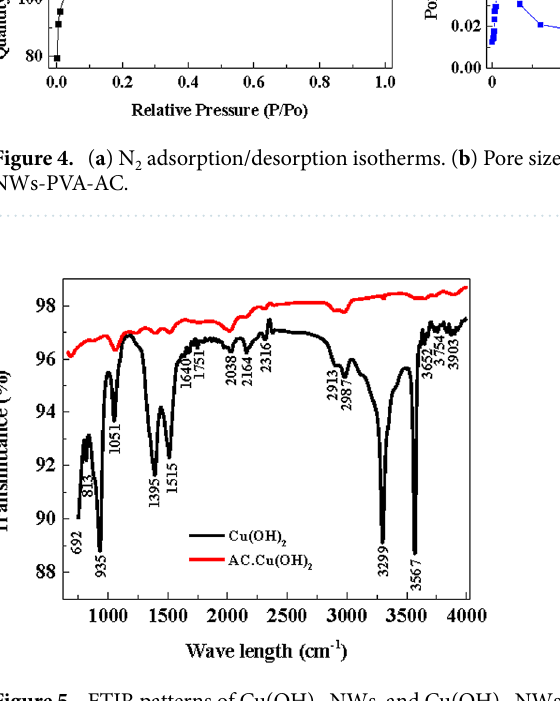
Figure 5. FTIR patterns of Cu(OH) 2 -NWs, and Cu(OH) 2 -NWs-PVA-AC